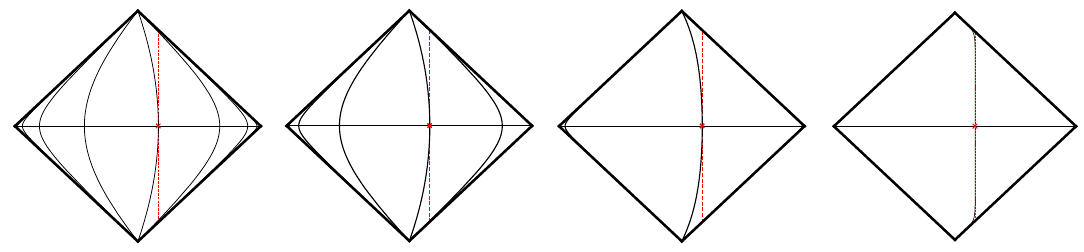
Figure 7. The curves describing the modular evolution of D ( x ) with x displaced ‘= 12 with respect to the midpoint of the interval, for L = 10, ‘ = 4 and (cid:12) = 20 ; 15 ; 5 ; 1 = 2 from left to right. As the temperature increases, thermal e(cid:11)ects start dominating over entanglement and, accordingly, modular evolution approaches time